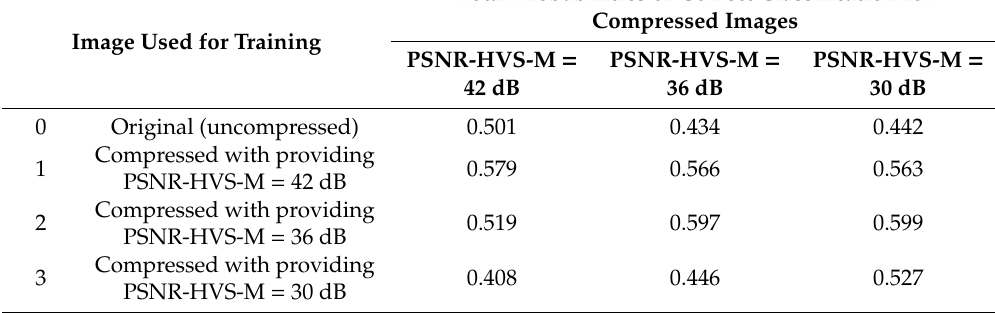
Table 5. Total probabilities of correct classification Pcc for different images depending upon “training” data.